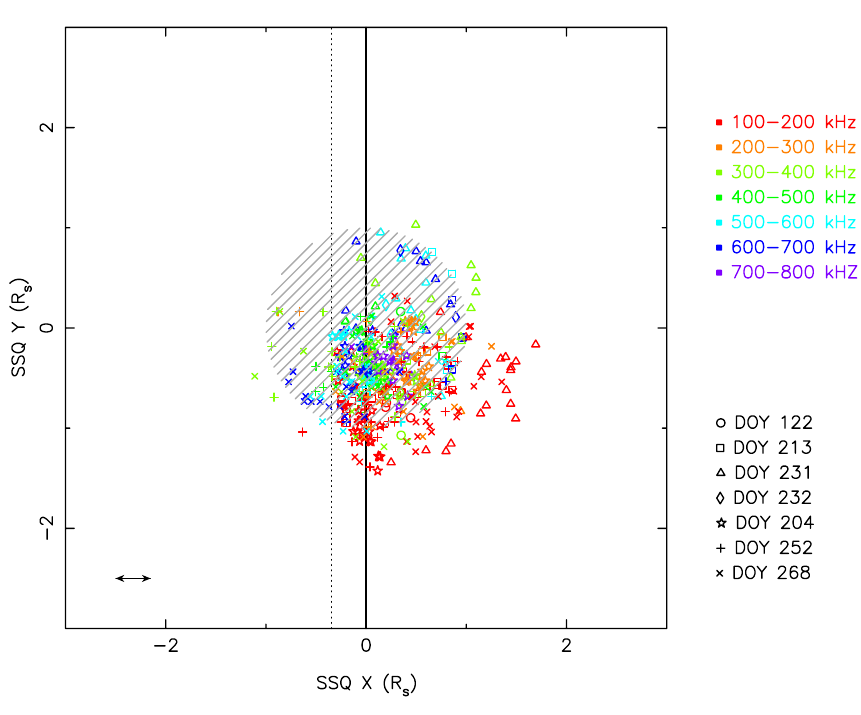
Fig. 5b. Same as Fig. 5a, but now in the x-y